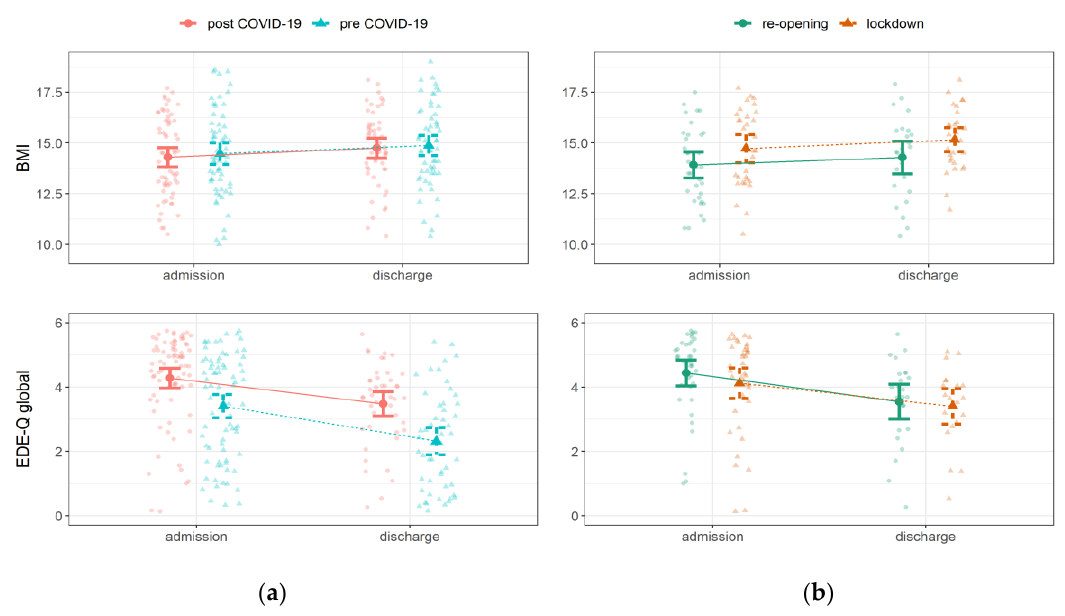
Figure 1. Changes in Body Mass Index (BMI) and Eating Disorder Examination Questionnaire (EDE- Q) during inpatient stay for the ( a ) whole sample and for ( b ) the pandemic